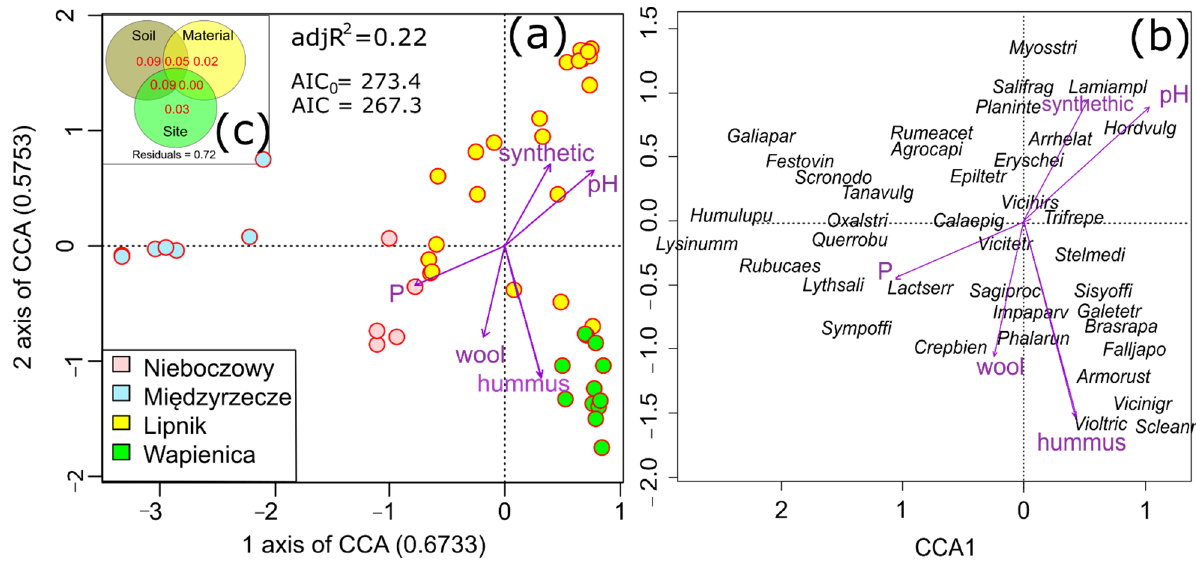
Figure 4. The biplots of the Canonical Correspondence Analysis (CCA): ( a ) diagram showing the study plots within the four sites and the environmental constraints as arrows (only the significant variables are shown); ( b ) diagram showing species; and ( c ) the Venn diagram representing the variance partitioning among the CCA constraints. Explanations: the first four letters denote the genus name and the next four denote the species names.